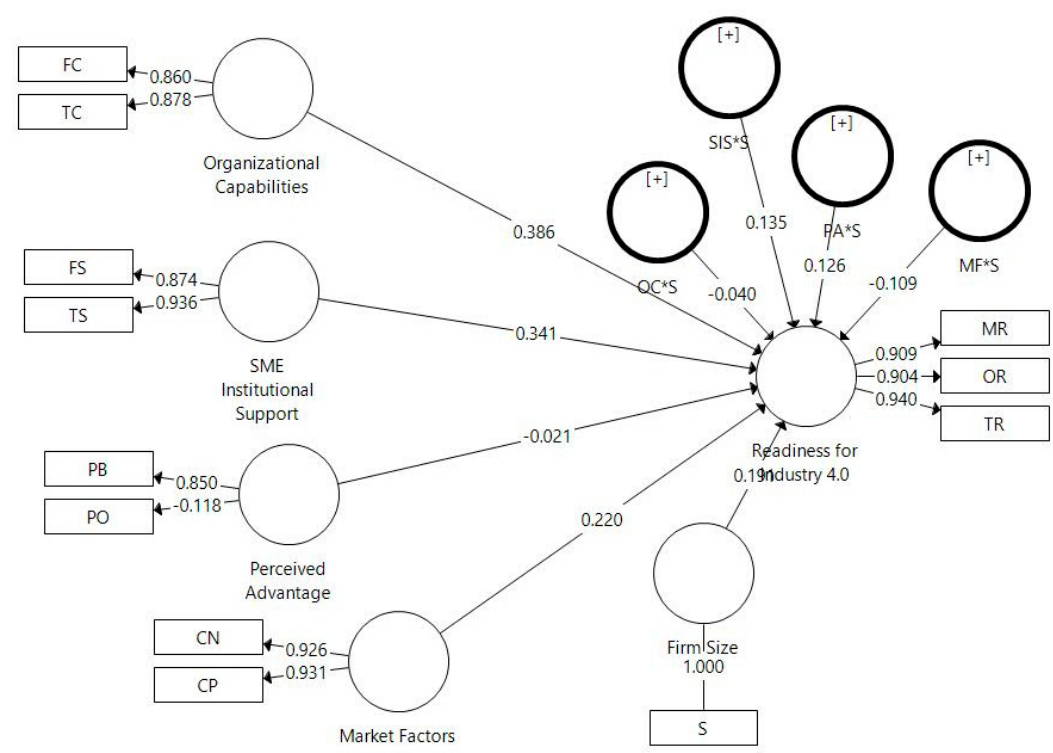
Figure 3. R 2 Adjusted Value .